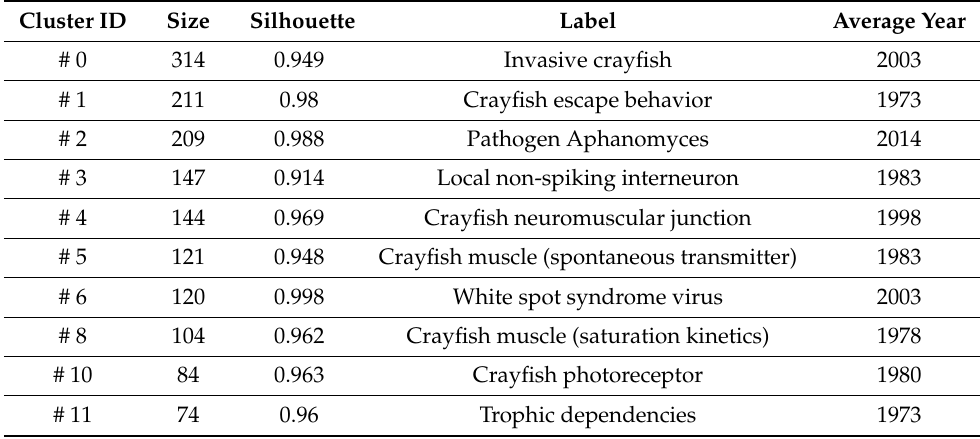
Table 8. Top 10 cluster IDs generated by